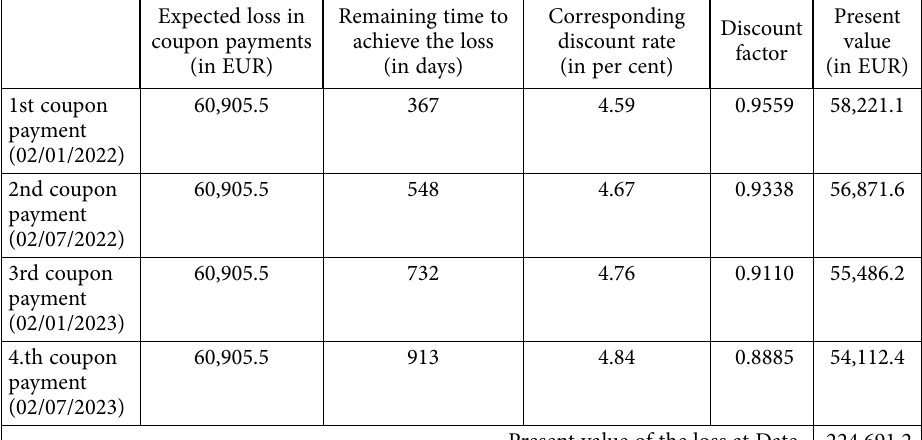
Table 6. Calculation of the expected interest income loss on Date